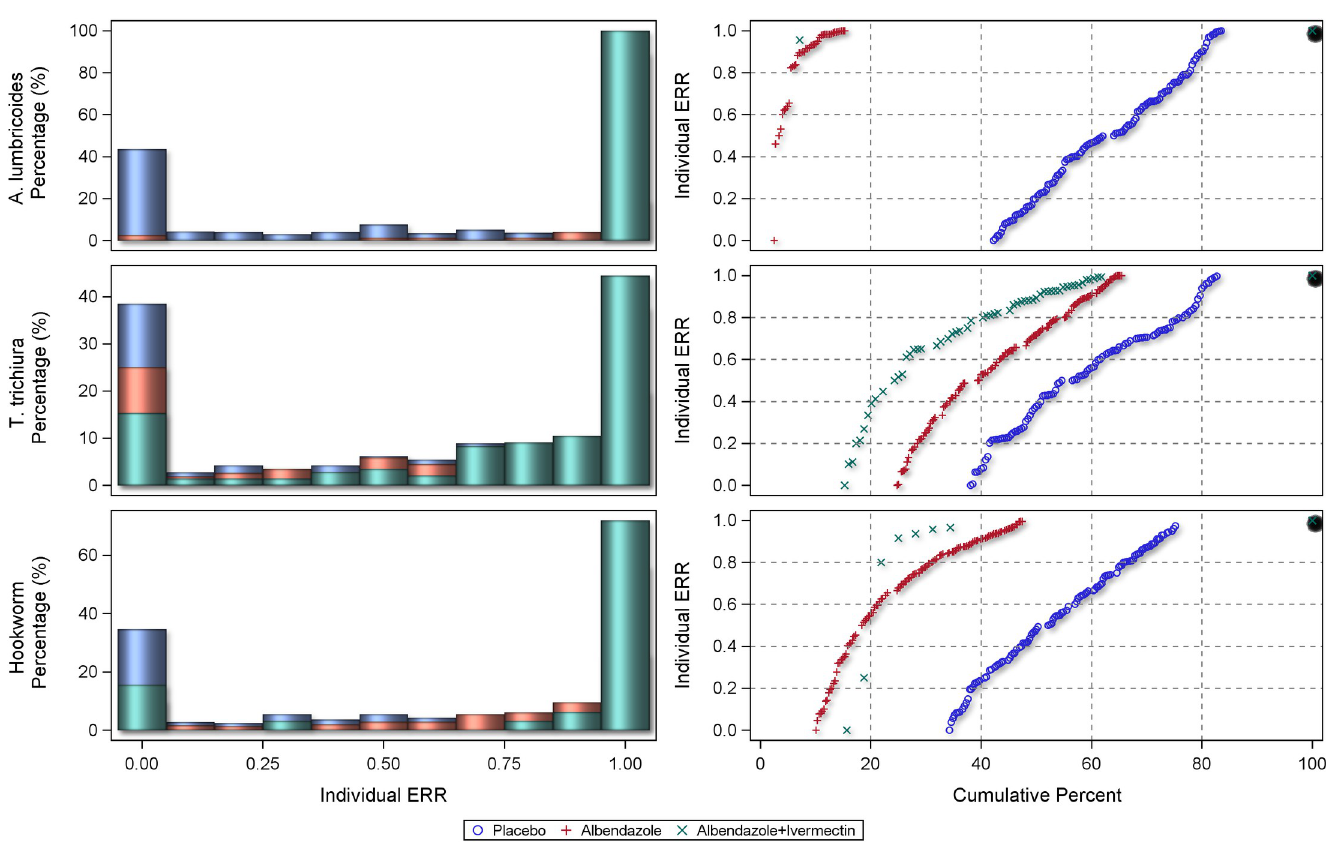
Fig 11. Distribution of individual responses in studies of 22–45 days follow-up for Ascaris lumbricoides , Trichuris trichiura and hookworm for albendazole and albendazole combinations. The right-hand plots show the proportions of people at a given ERR with colours related to placebo or a drug. The left-hand plots show cumulative distribution of ERR in people treated with a drug from 0 to